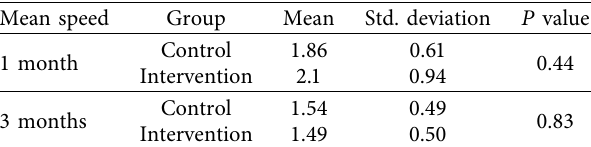
Table 4: Mean speed of healing in the two groups at 1 and 3 months ( n � 11 in each